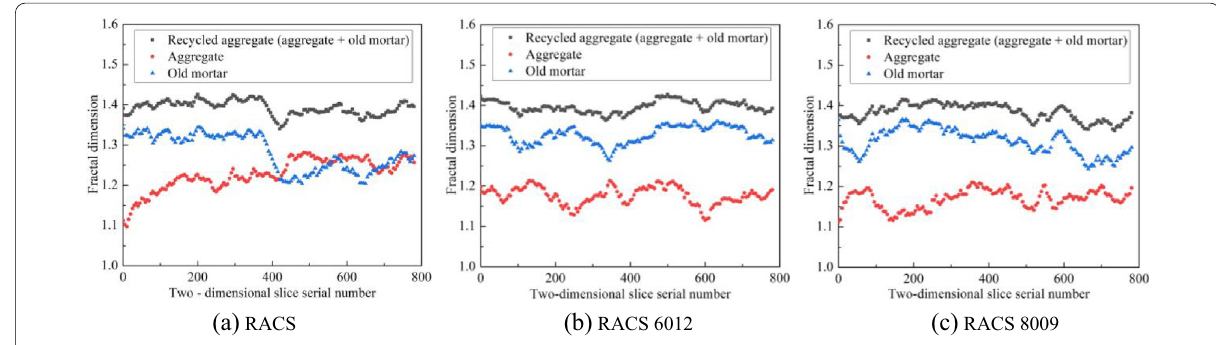
Fig. 17 Fractal dimension characteristics of recycled aggregate